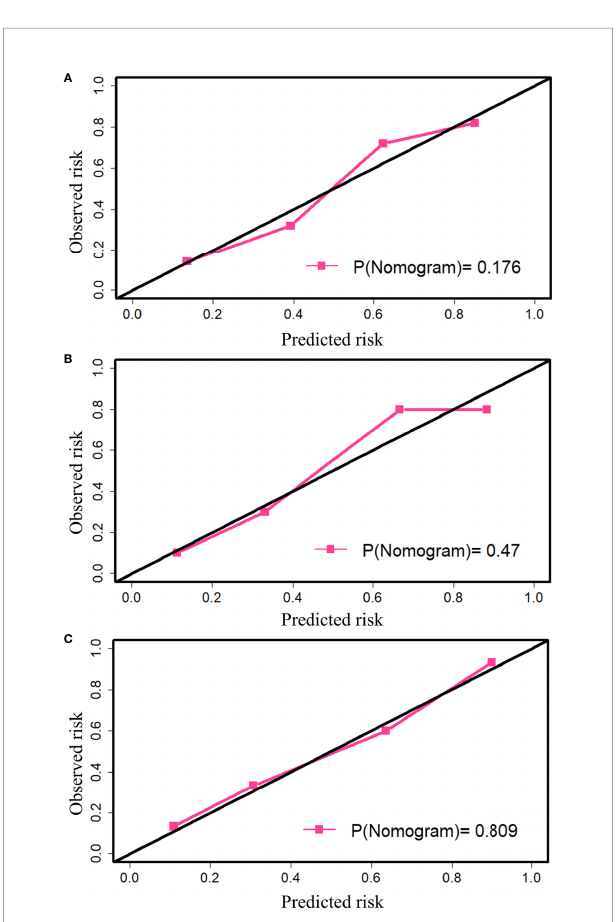
FIGURE 5 | The calibration plot of nomogram. (A) Calibration in the training cohort. (B) Calibration in the internal validation cohort. (C) Calibration in the external validation cohort. The black diagonal indicates the ideal fi t, and in this case, the metastasis probability predicted by the nomogram is the same as the actual observed transition probability. The pink line indicates the fi tting of the nomogram. The closer it is to the black line, the better is the fi t. P-value was calculated by the Hosmer-Lemeshow